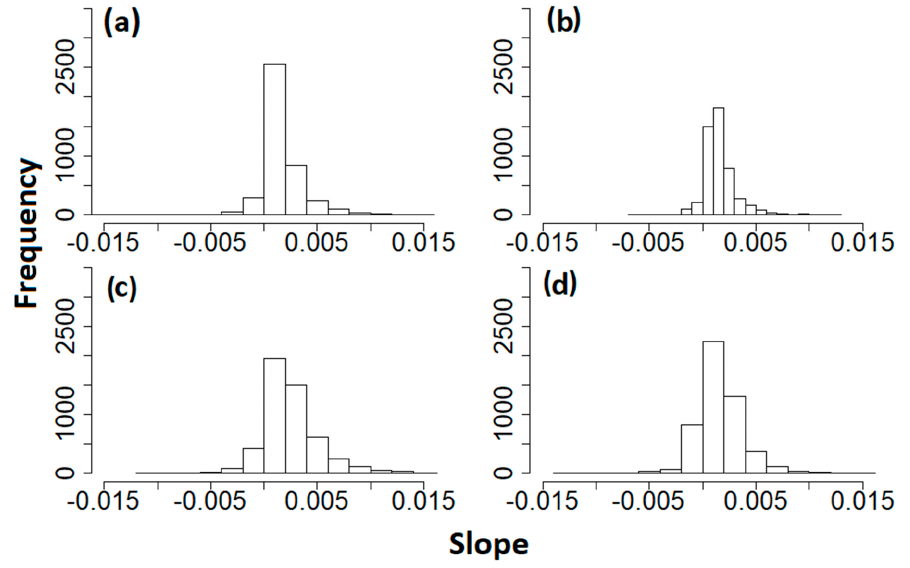
Figure 5. Histograms for trend slopes derived from ( a ) EVI, ( b ) MSAVI, ( c ) NDVI, and ( d ) NDMI. Different plots (Figure 6) of calculated trend slopes for all four indices show correla- tion between EVI, MSAVI, NDVI, and NDMI and their statistical distribution. Overall correlation values between EVI, MSAVI, and NDVI are quite high, up to 0.98. On the other hand, lower values of correlation between NDMI with other indices were observed, with the maximum reaching up to 0.58. Nonetheless, all indices showed a dominant greening pattern. The box plots and QQ (quantile-quantile) plots show that all indices follow simi- lar statistical distribution. The prominent presence of extreme values (especially positive) is indicated by data points falling on the line in the middle and deviating away from the line (above blue line for positive values and below blue line for negative values) forming heavy tails in the QQ plots. This is also reflected by the data points falling outside the upper and lower whisker in the box plot.